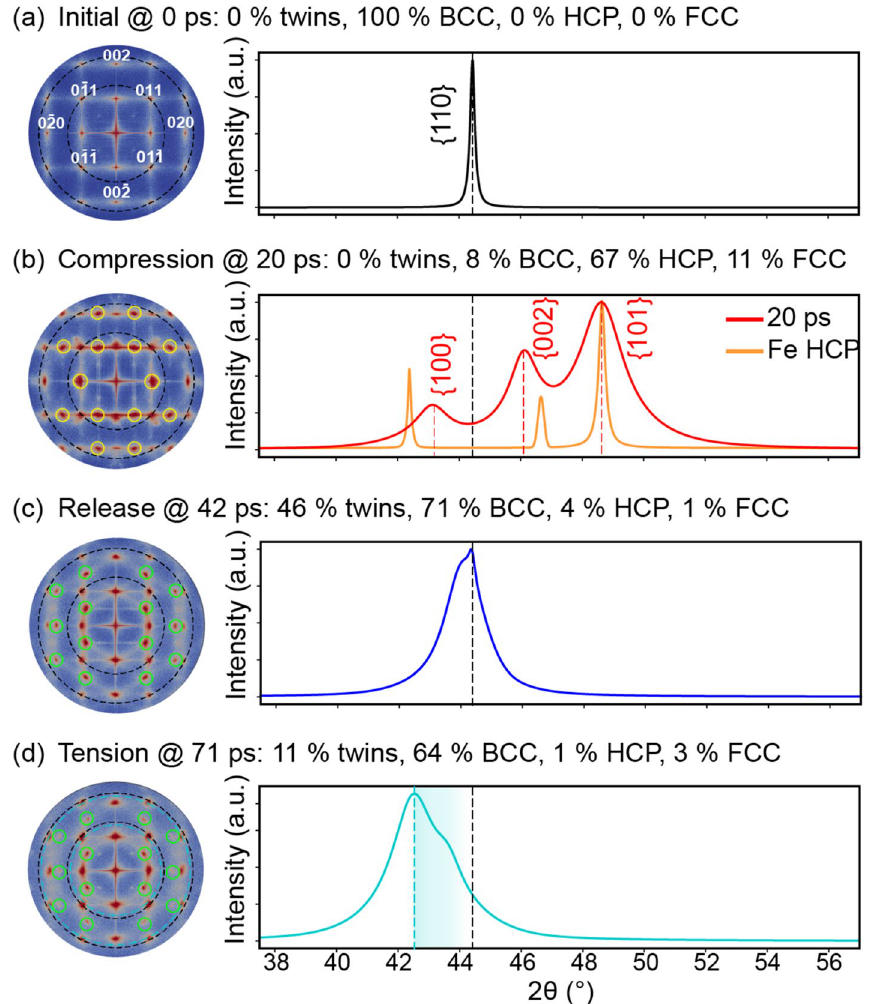
Figure 6. Virtual diffraction for BCC Fe shocked along [110] at ( a ) 0 ps, ( b ) 20 ps, ( c ) 42 ps, and ( d ) 71 ps after impact. Each SAED corresponds to a [100] zone axis, a 1.25-Å −1 radius, and 200-keV electron irradiation. Each XRD represents powder diffraction for Cu-Kα X-rays. For association with diffraction signatures, discrete quantifications of twins and phases are provided in the subfigure labels. For reference, new SAED spots are indicated with solid circles, and the locations of SAED spots and the XRD peak are indicated by dotted lines color-coded by time step. The SAED spots for low-order planes are indexed. SAED patterns are plotted using Paraview 66 , version 5.7 from https:// www. parav iew.